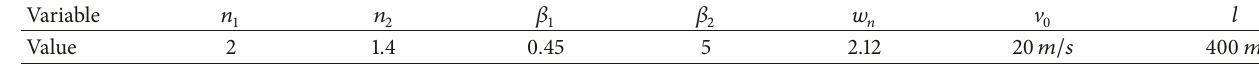
Table 2: Parameters of random road roughness.